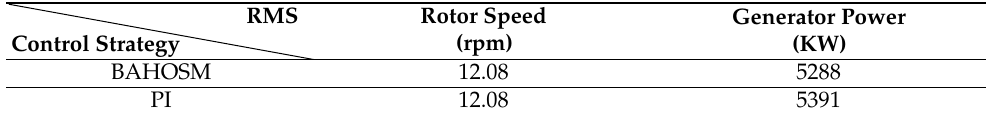
Table 4. RMS values of the rotor speed and generator power for Case 2.